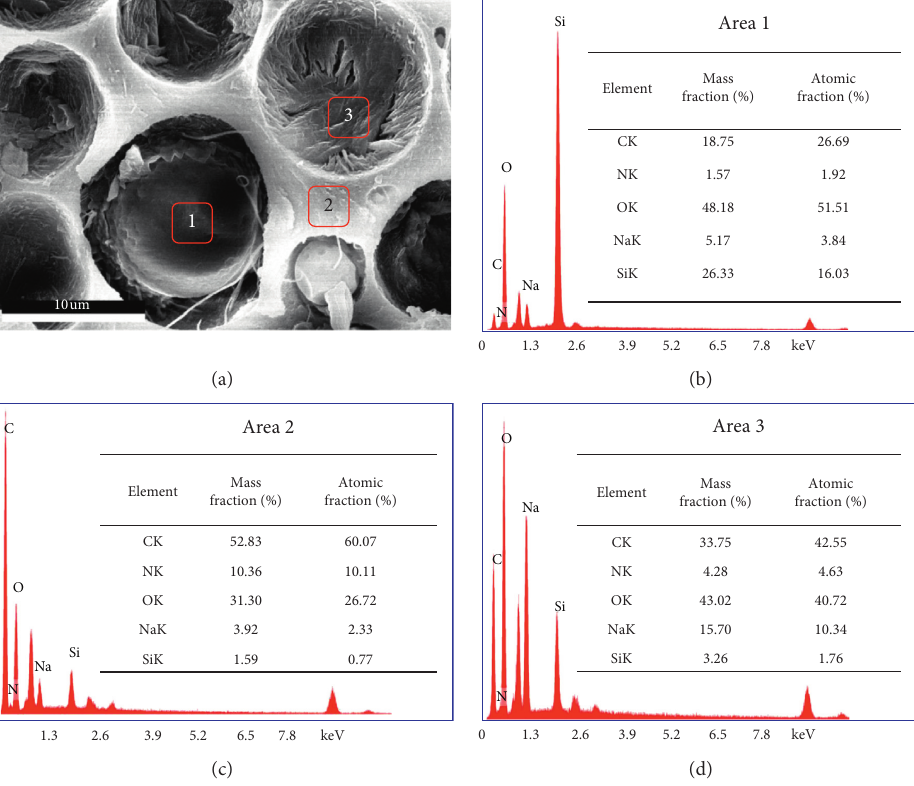
Figure 7: The morphologies of samples catalyzed by different types and additive number of